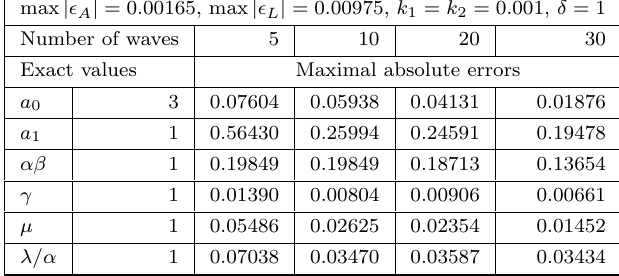
Table 3. Maximal absolute errors (wave characteristics, macrodeformation